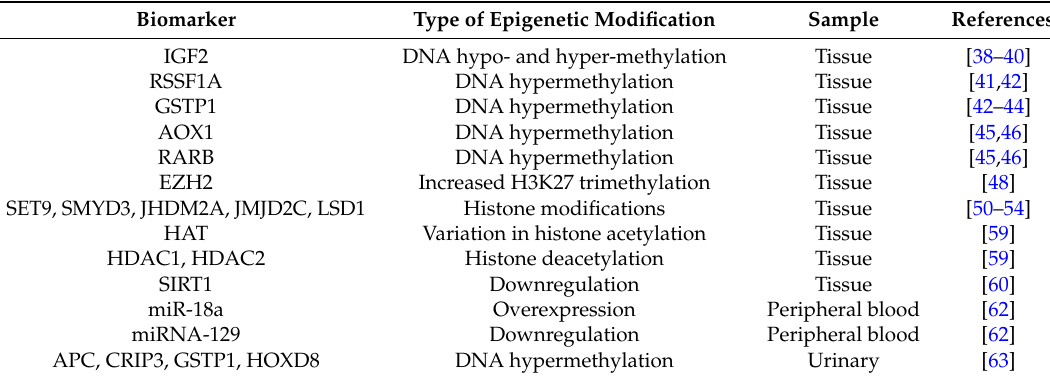
Table 1. Overview of prostate cancer epigenetic